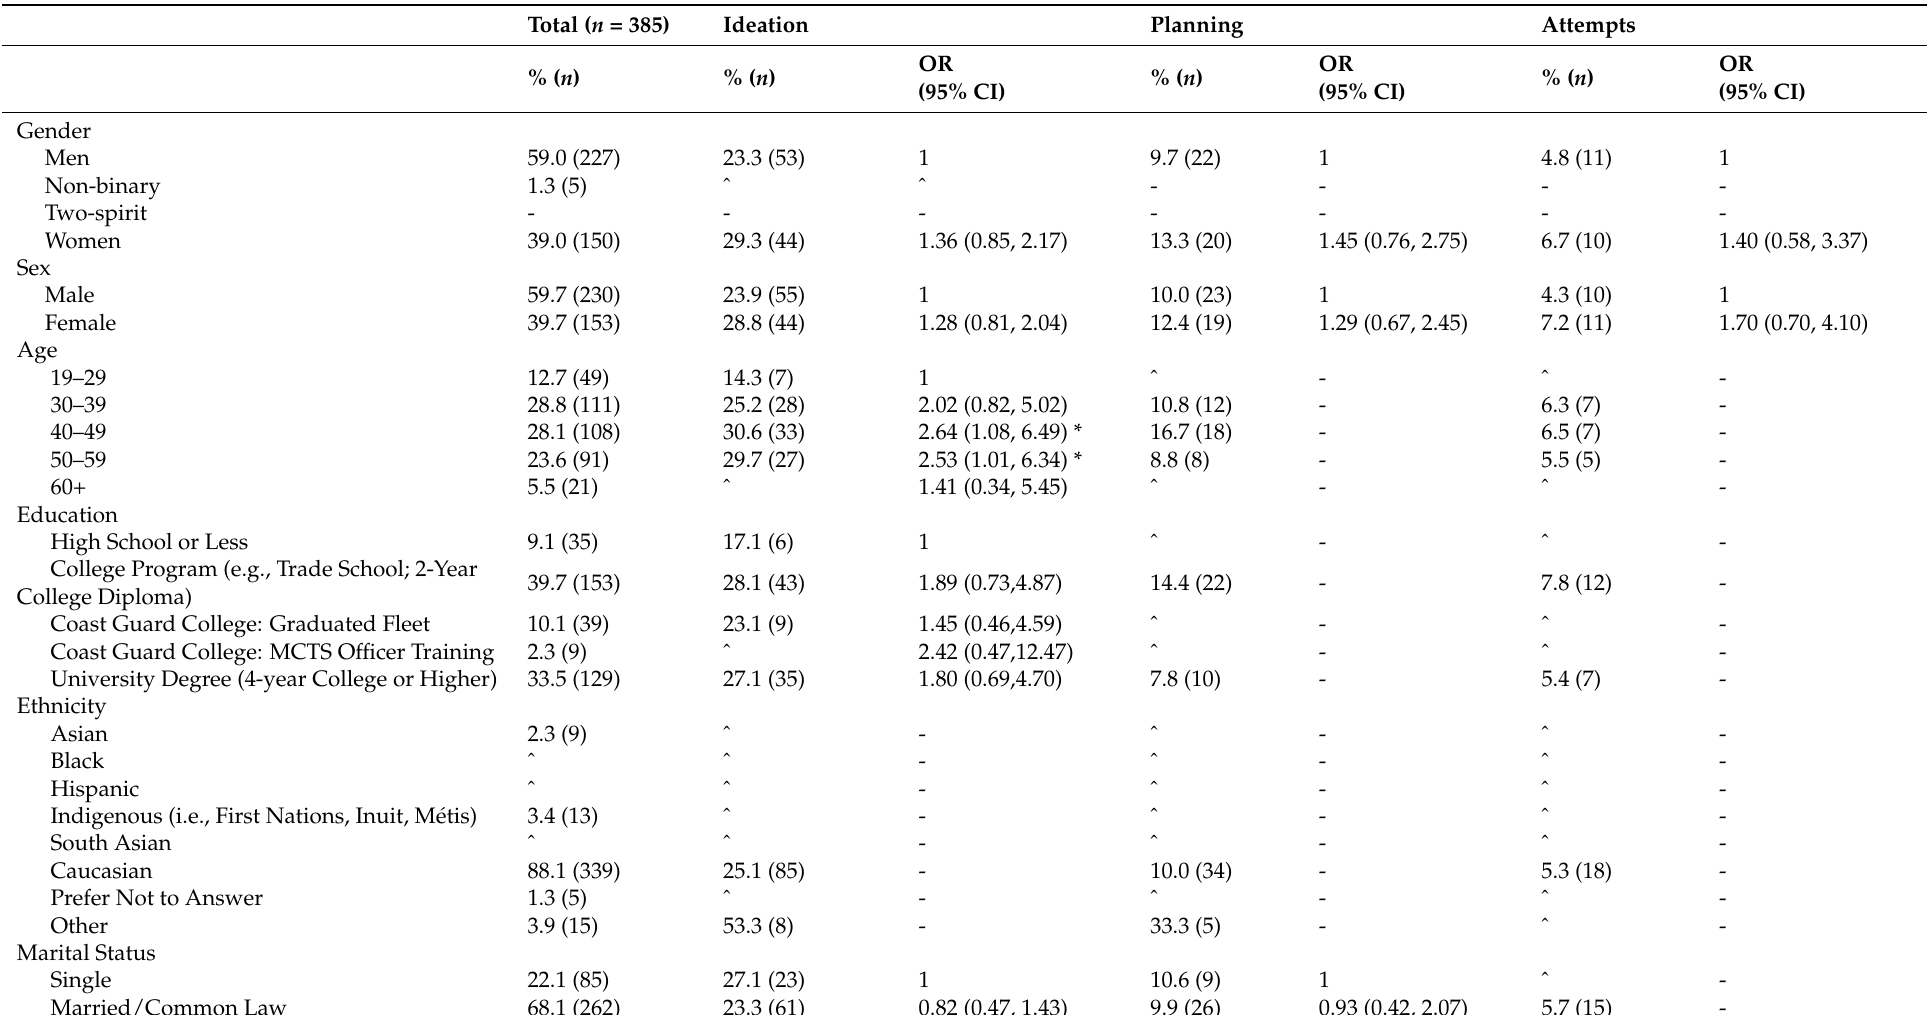
Table 2. Associations between Sociodemographic Covariates and Lifetime Suicidal ideation, planning, and attempts. Total ( n =